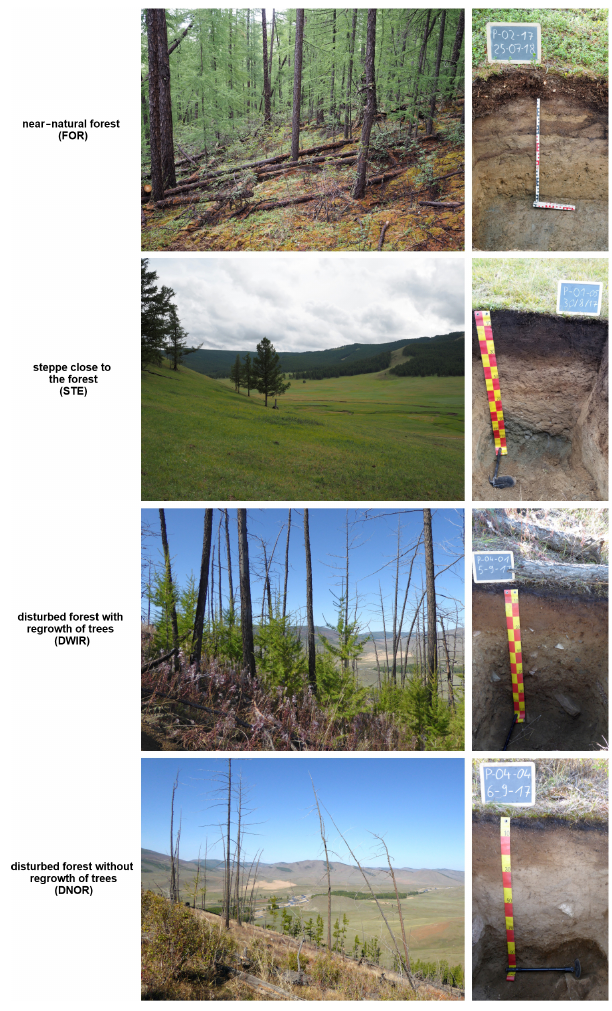
use of a SediGraph (Micromeritics). Bulk density was esti- mated in the field (Jahn et al., 2006) and measured on undis- turbed samples in the laboratory. All element concentrations in the fine earth were converted to element stocks per square metre considering rock fragment content and bulk